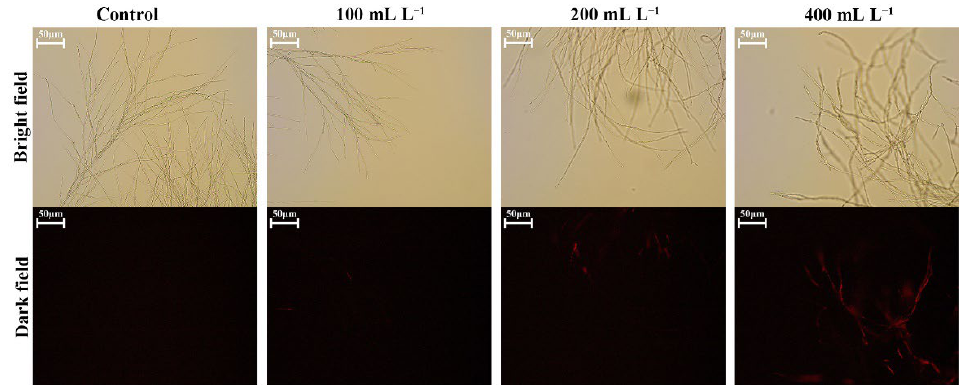
Figure 6. The Effect of SS with different concentrations on the cell membrane permeability of mycelia of D. glomerata , as demonstrated by propidium iodide staining.